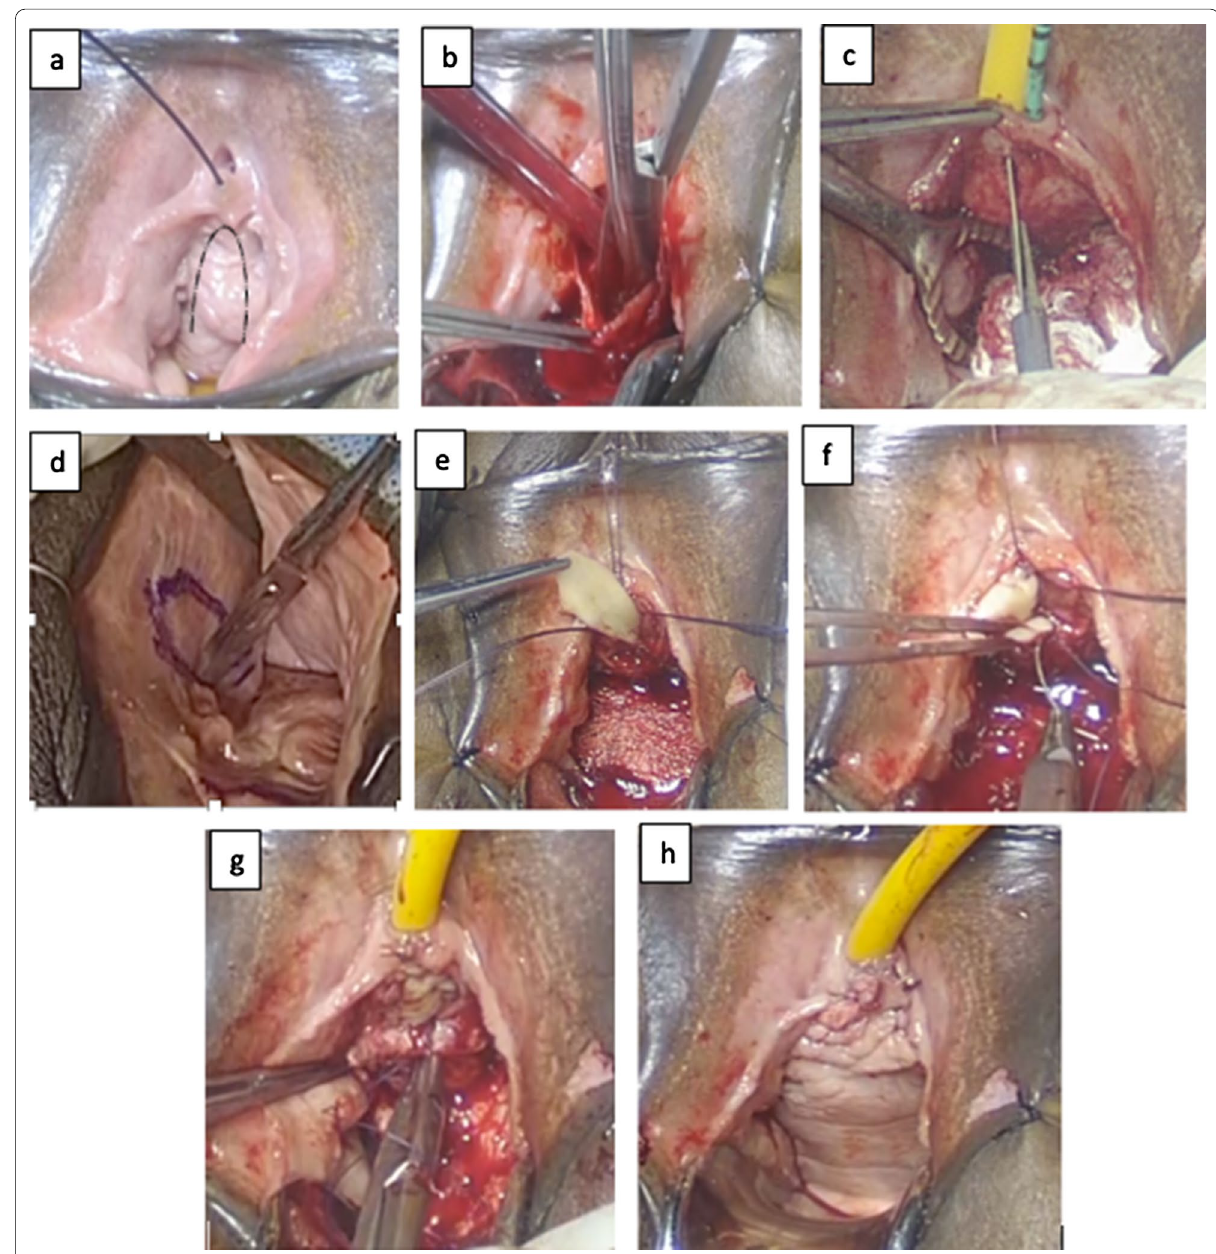
Fig. 3 intraoperative pictures, a inverted U Incision on anterior vaginal wall b development of paraurethral flaps, c incision of ventral surface of strictured urethra, d Graft harvest, e Graft placement and anastomosis, f Completion of graft anastomosis, g Paraurethral tissue flap closure, h Anterior vaginal wall flap